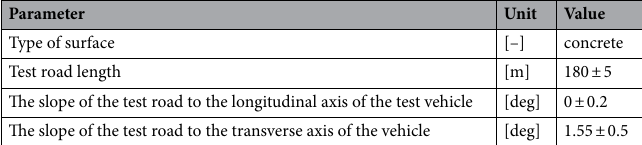
Table 3. Test road parameters for the truck acceleration tests (Source: Authors).